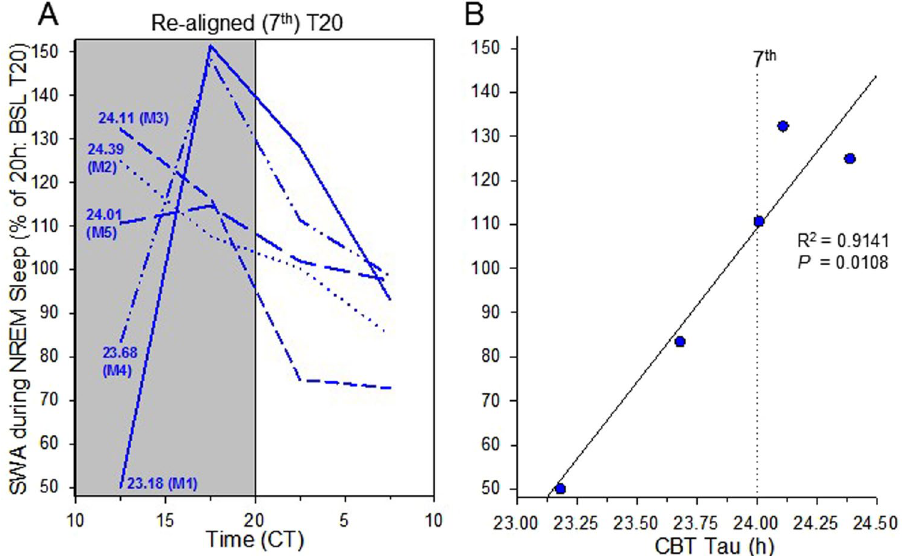
Figure 6. Effects of individual period on NREM sleep slow wave activity (SWA). ( A ): Individual time course of corrected EEG SWA based upon the individual animal’s CBT period (for the re-aligned T20 cycle). The numbers at the first SWA interval indicate the individual animal’s period (for the 5 mice M1 to M5). Individual EEG SWA was expressed relative to the 20 hours of the baseline T20 cycle ( = 100%). ( B ): Correlations between NREM SWA during the first “re-aligned” interval with the individual animal’s CBT period. Pearson’s correlation coefficient (R-squared) and its P value are indicated on the